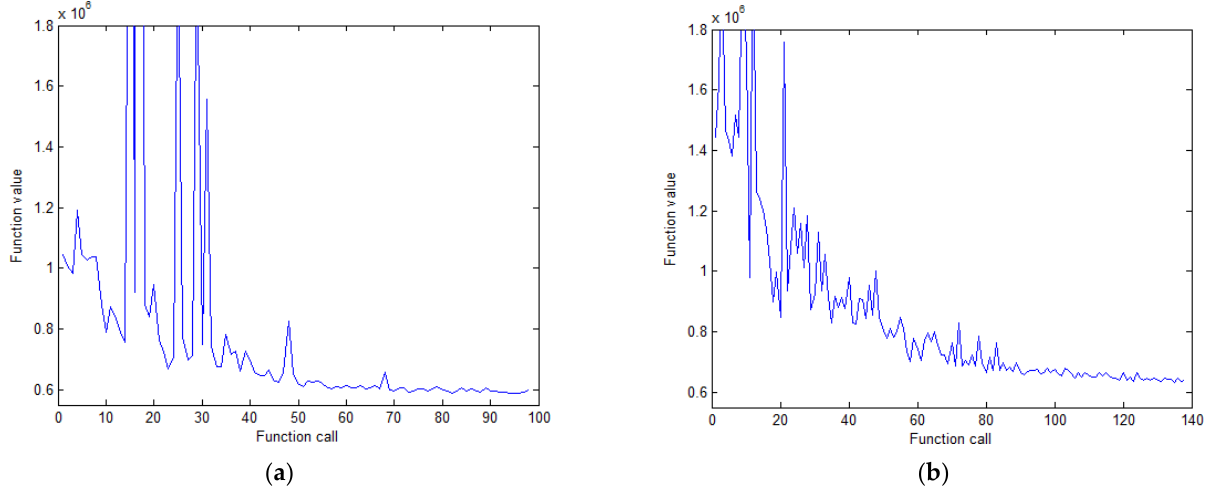
Figure 8. The change in the objective function call during optimization. ( a ) PMFSG; ( b ) IPMSG. The optimized designs of IPMSGs and PMFSGs and the magnetic flux density at the rated mode are shown in Figure 6a,b, respectively. The optimized values of the varied